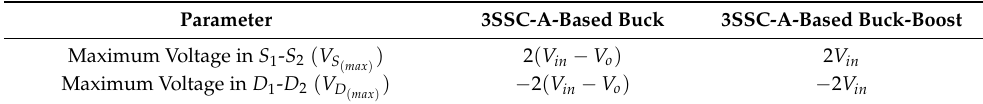
Table 3 summarizes the maximum voltage stress across all power semiconductors during a period of operation of the 3SSC-A-based buck and buck-boost converters. Table 3. Voltage Stress across Semiconductors. Parameter